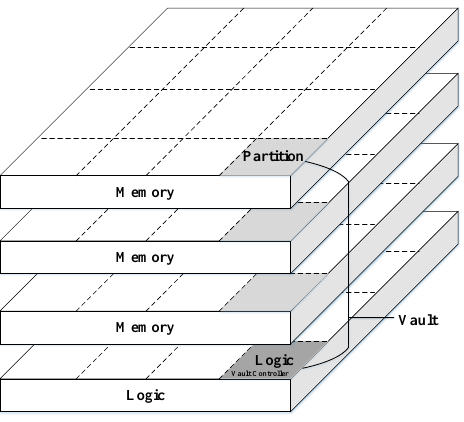
Figure 9. High-level architecture of Hybrid Memory Cube (HMC) (adapted from